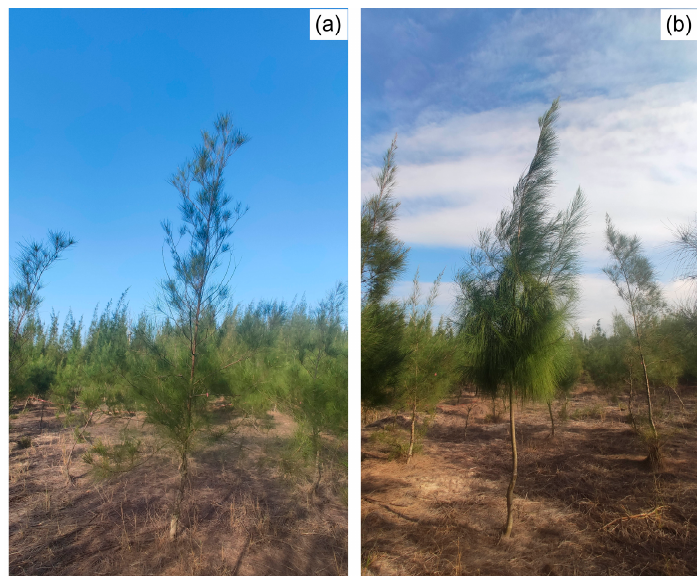
Figure 7. C. Equisetifolia with different crown shapes ( a , b ) in the field. Figure 7. C. equisetifolia with different crown shapes ( a , b ) in the